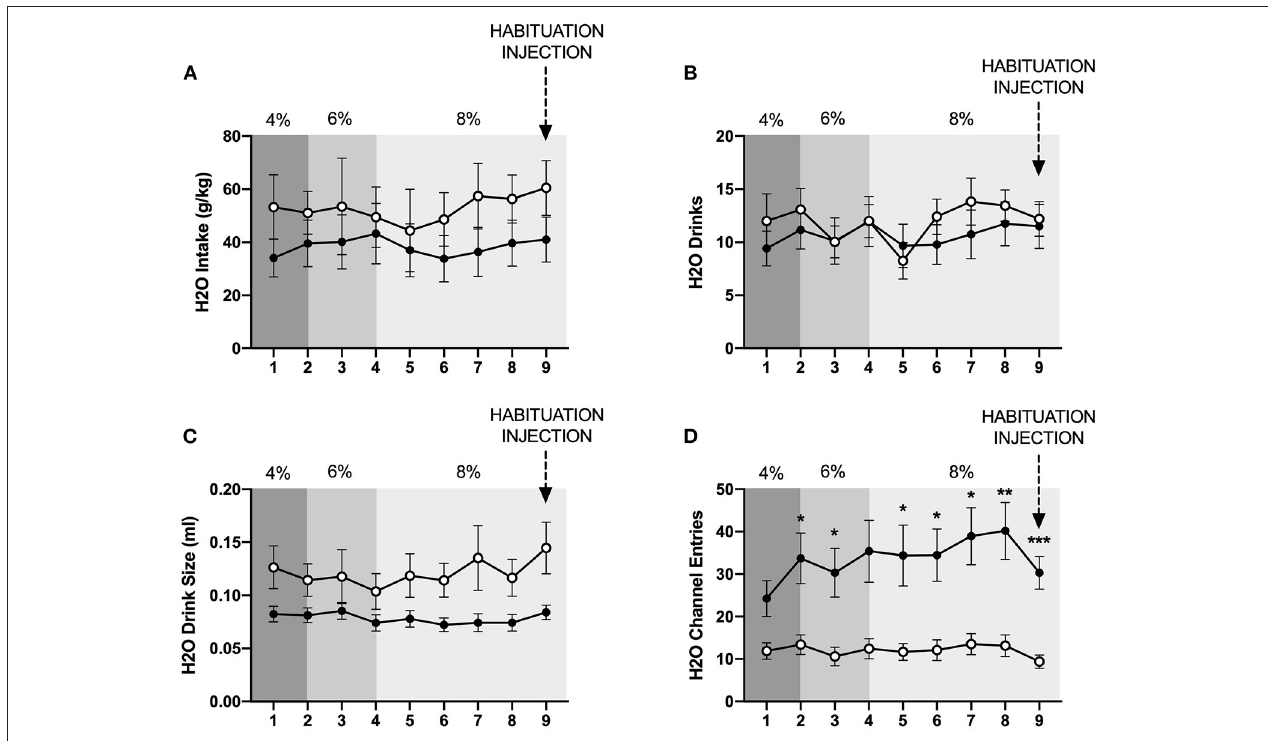
FIGURE 3 | Cumulative 24 h baseline water data. (A) Water intake in g/kg. (B) Number of water drinks. (C) Water drink size. (D) Water channel entries. While no significant differences in g/kg water intake or number of water drinks were observed, socially-housed mice had significantly larger water drink size than individually-housed mice. As observed with the ethanol channel, individually-housed mice made significantly more non-consummatory water channel entries than socially-housed mice. * p < 0.05, ** p < 0.01, *** p < 0.001, compared to opposite housing condition. Data represented as mean ± SEM. n =